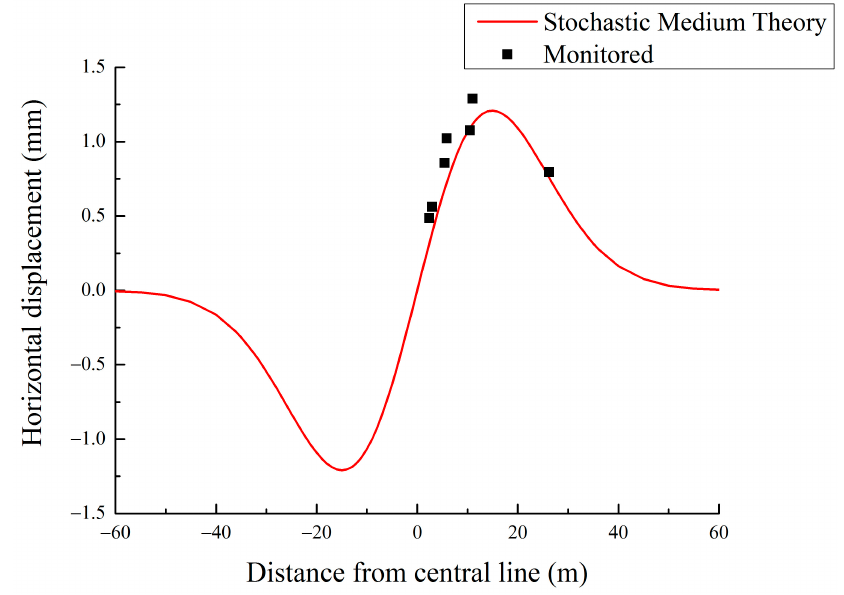
Figure 10. Comparison of the horizontal displacement between the stochastic medium theory and on-site monitoring .